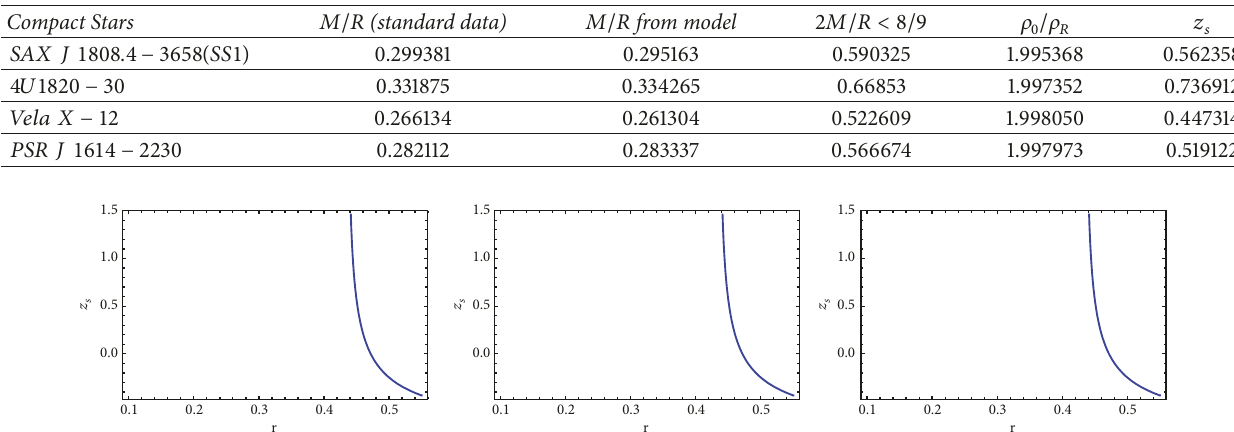
Figure 21: This figure represents the variation of 𝑧 𝑠 versus 𝑟 (km) for the strange star taking 𝛽 = 0.009 , 𝛽 = 0.010 , and 𝛽 = 0.011